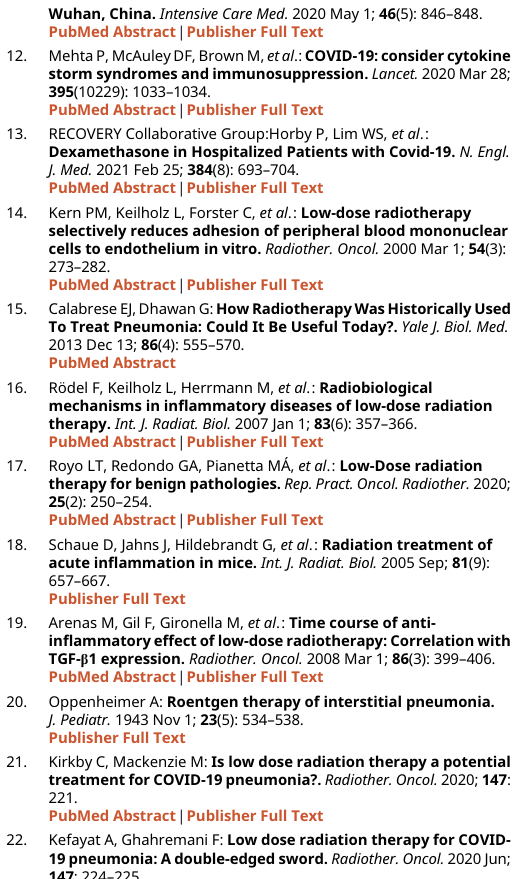
Figshare: PRISMA checklist for ‘ Effectiveness of low dose radiation therapy in COVID-19 patients globally: A systematic review ’ . https://doi.org/10.6084/m9.figshare.c.5757326.v1 32 Data are available under the terms of the Creative Commons Attribution 4.0 International license (CC-BY